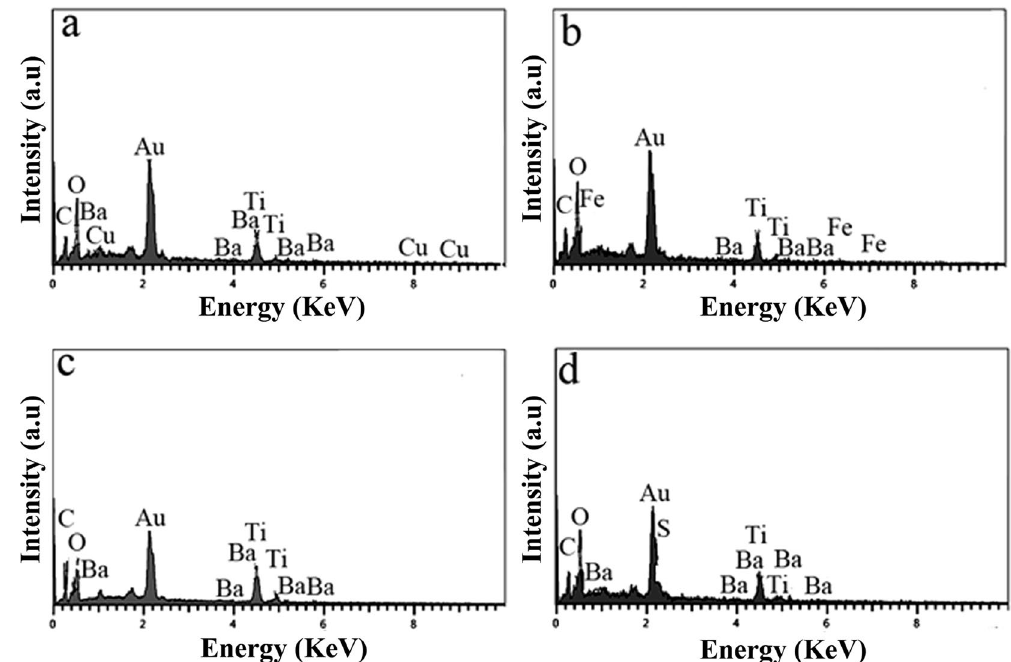
Figure 4. EDX of ( a ) Cu–BaSO 4 –BaTiO 3 , ( b ) Fe–BaSO 4 –BaTiO 3 , ( c ) N–BaSO 4 –BaTiO 3 and ( d ) S–BaSO 4 – BaTiO